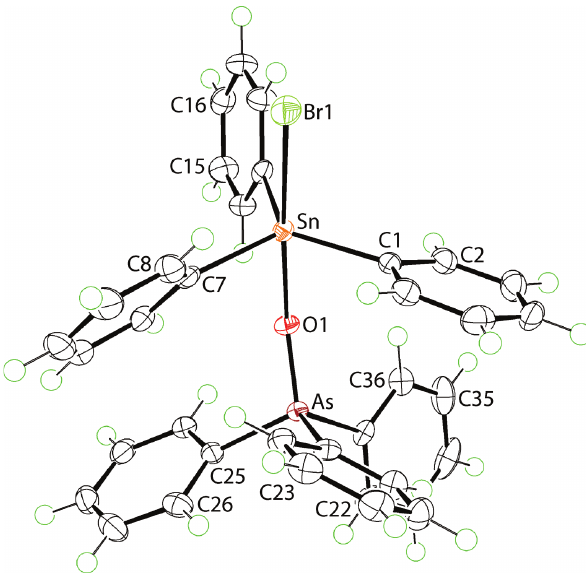
Table 1: Data collection and